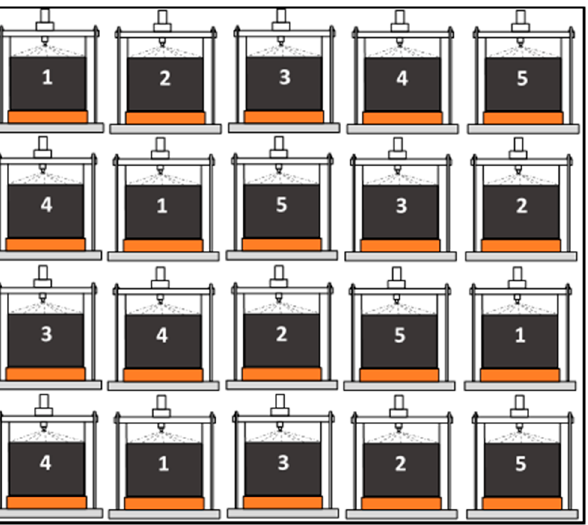
Figure 5. Schematic diagram of the experimental design. The numbers 1–5 represent treatment as 1 = unamended or control (BS), 2 = wheat straw (+S), 3 = broccoli residue (+CR), 4 = broccoli residue and wheat straw (+CR+S) and 5 = broccoli residue and washed wheat straw (+CR+Sw). All treatments were replicated four times.